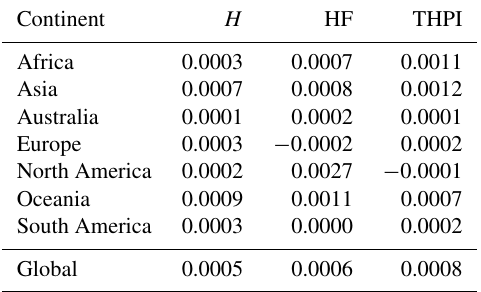
Table 5. A comparison of the mean annualized difference in hu- man modification values for changes from 1990 to 2015 ( H ; 1990– 2015), human footprint (HF; 1993–2009; Venter et al., 2016), and the temporal human pressure index (THPI; 1995–2010; Geldmann et al., 2019b). Mean annualized mean difference is calculated as the mean value of the difference in H values divided by the num- ber of years (e.g., H mad = ( H 2015 − H 1990 ) / 25), for each continent. Note that Oceania extends below Papua New Guinea (excluding the country of